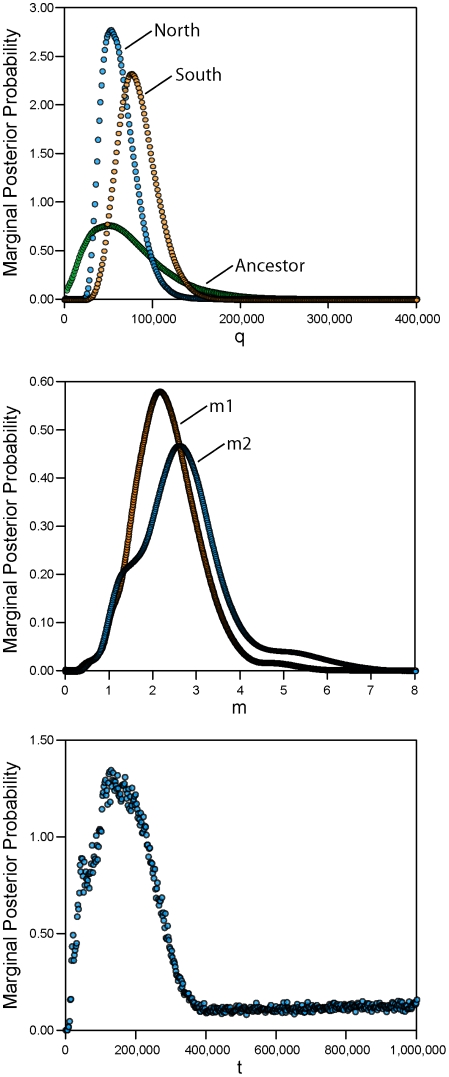
Population divergence genetic parameters.Marginal posterior probability distributions for the isolation-with-migration demographic parameters.